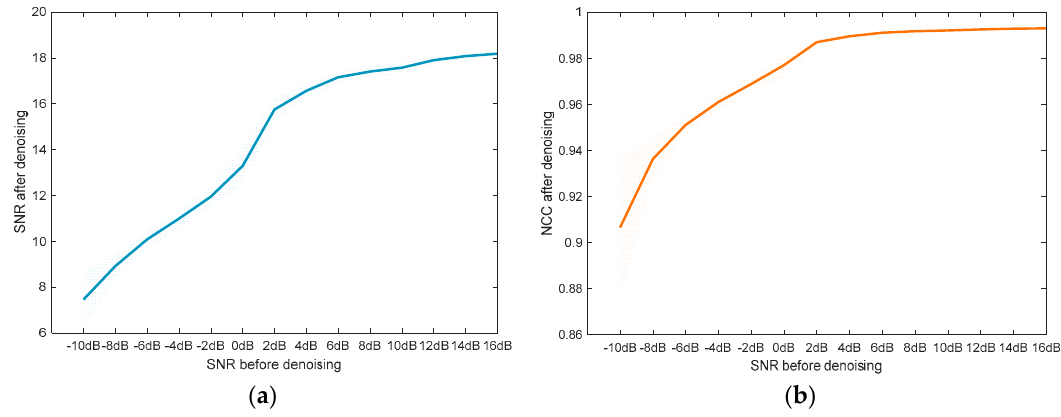
Figure 8. Evaluation of robustness of AVMDSSA: ( a ) SNR values after denoising; ( b ) NCC values after denoising. The bold solid line in each plot represents the mean value of corresponding index, and the semi-transparent regions are the value space of each index between its positive and negative standard error.